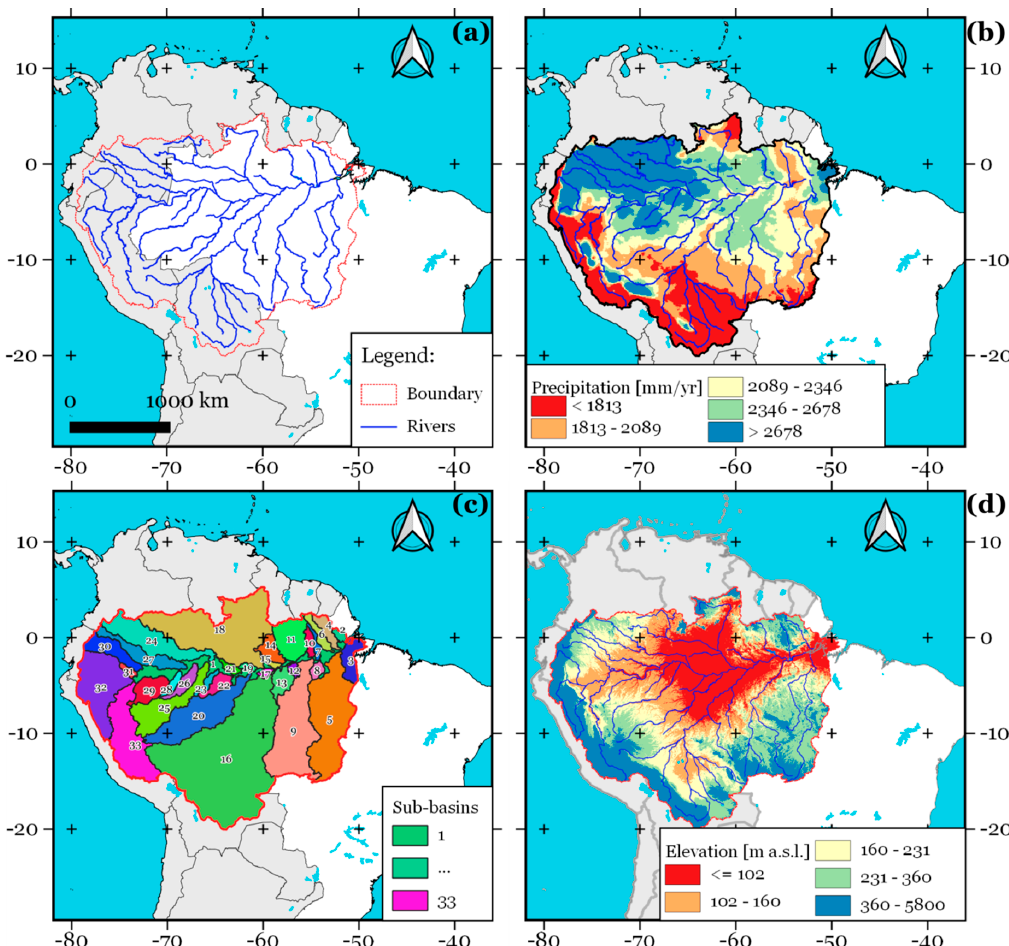
Figure 1. The study area: ( a ) the hydrographic network; ( b ) mean annual rainfall from the Climate Hazards Group InfraRed Precipitation with Stations (CHIRPS) [55] for the reference period 2000–2018; ( c ) sub-basins of the ARB according to Mayorga et al. [52] where 1, Amazonas-Solimões; 2, Macapá; 3, Marajó-Pará; 4, Jari; 5, Xingu; 6, Paru de Este; 7, Maicuru; 8, Curuá-Una; 9, Tapajós; 10, Curuá; 11, Trombetas-Nhamundá; 12, Mamuru; 13, Ilha Tupinambarana; 14, Uatumã; 15, Urubu; 16, Madeira; 17, Madeirinha; 18, Negro; 19, Manacapuru; 20, Purus; 21, Badajós; 22, Coari; 23, Tefé; 24, Japurá-Caquetá; 25, Juruá; 26, Jutaí; 27, Içá-Putumayo; 28, Jandiatuba; 29, Javari-Yavarí; 30, Napo; 31, Nanay; 32, Marañón; and 33, Ucayali; ( d ) terrain elevation based on 250-m Digital Elevation Model—Shuttle Radar Topographic Mission (DEM-SRTM) images [56].